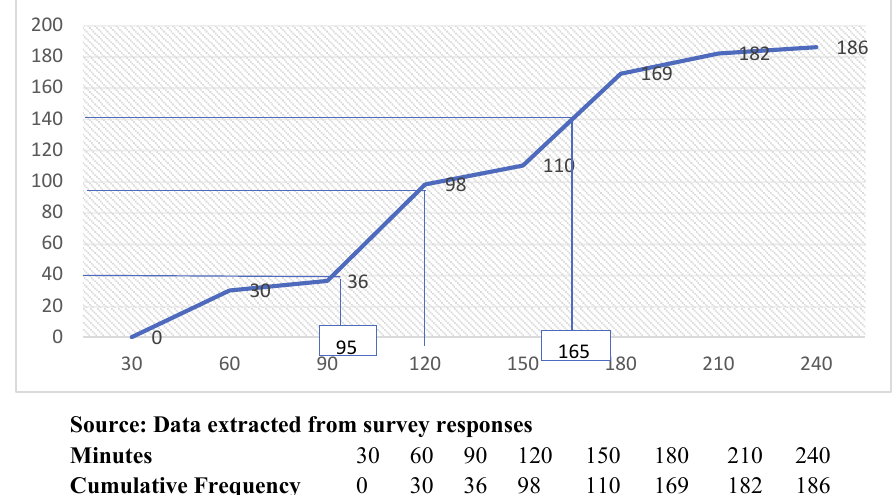
Fig. 1. Time spent by the respondents in the fitness center (in